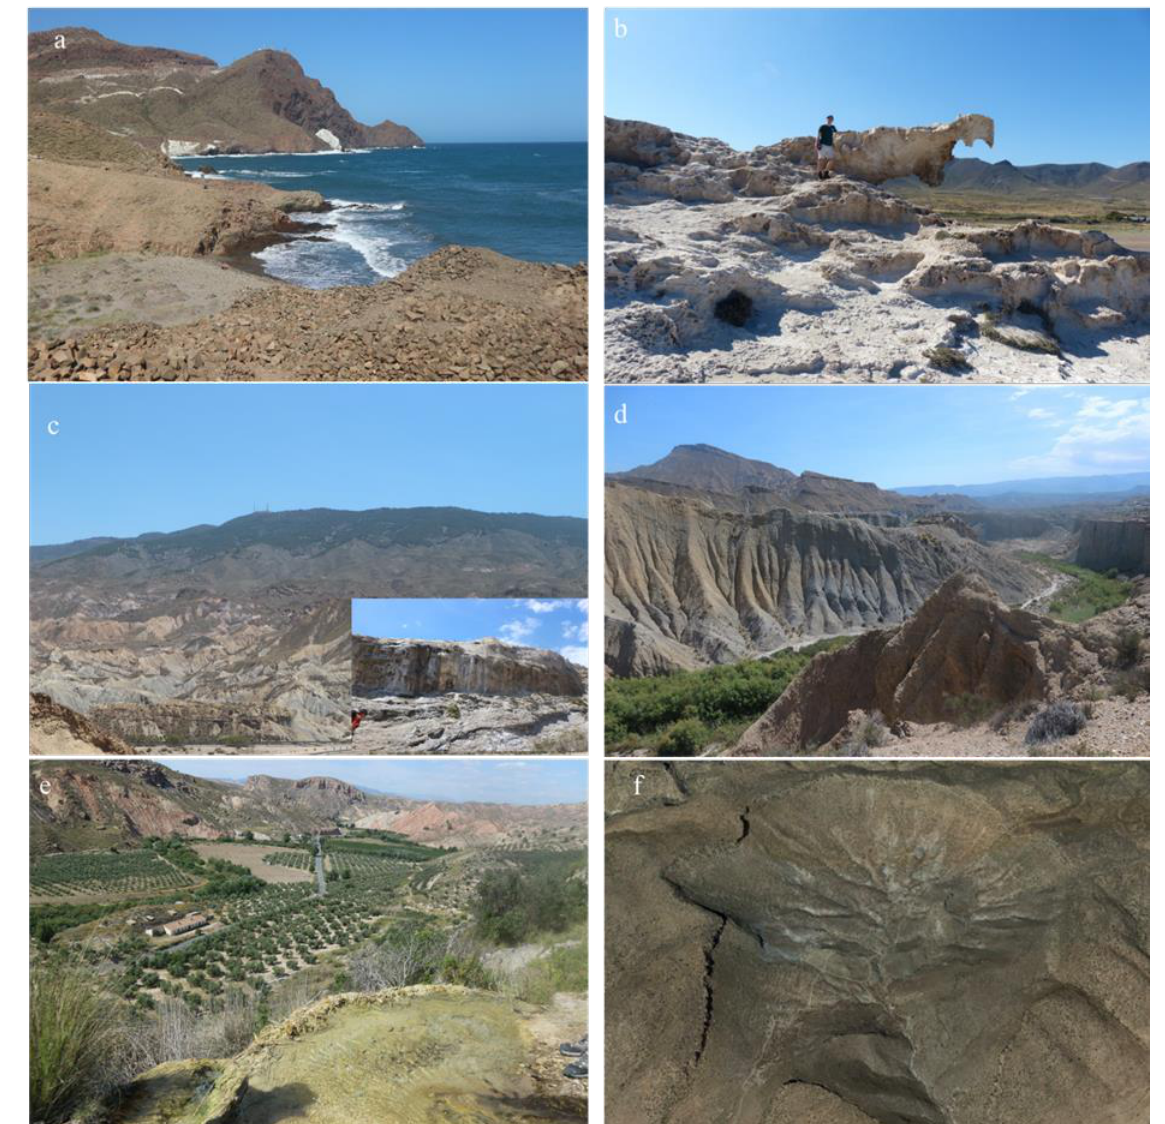
Figure 9. Illustration of the top-ranked geosites based on mean scenic beauty ratings by the three respondent groups. ( a ) Punta Baja (geosite 4) with andesitic columns (© G. Tessema, May 2019); ( b ) Los Escullos (geosite 10) with fossil dunes (© J. Poesen, May 2019); ( c ) Bar Alfaro (geosite 24) view on badlands near rambla de Tabernas with exposures of flysch and marls, inset photo — travertine features (© G. Tessema, May 2019); ( d ) Mini Hollywood (geosite 25) with view on badlands near rambla de Tabernas (© G. Tessema, May 2019); ( e ) Alicun de las Torres (geosite 30) with flowing water on travertine (© G. Tessema, 2019. ( f ) El Hoyazo (geosite 34) — eroded volcanic cone and coral reef (atoll) (© Google Earth Images, May 2020). These geosites are also among those in the top rank in terms of scientific value rating. See Figure 1b for their location; Table A1 in Appendix A for their description, Table A4 in Appendix A for their scenic beauty